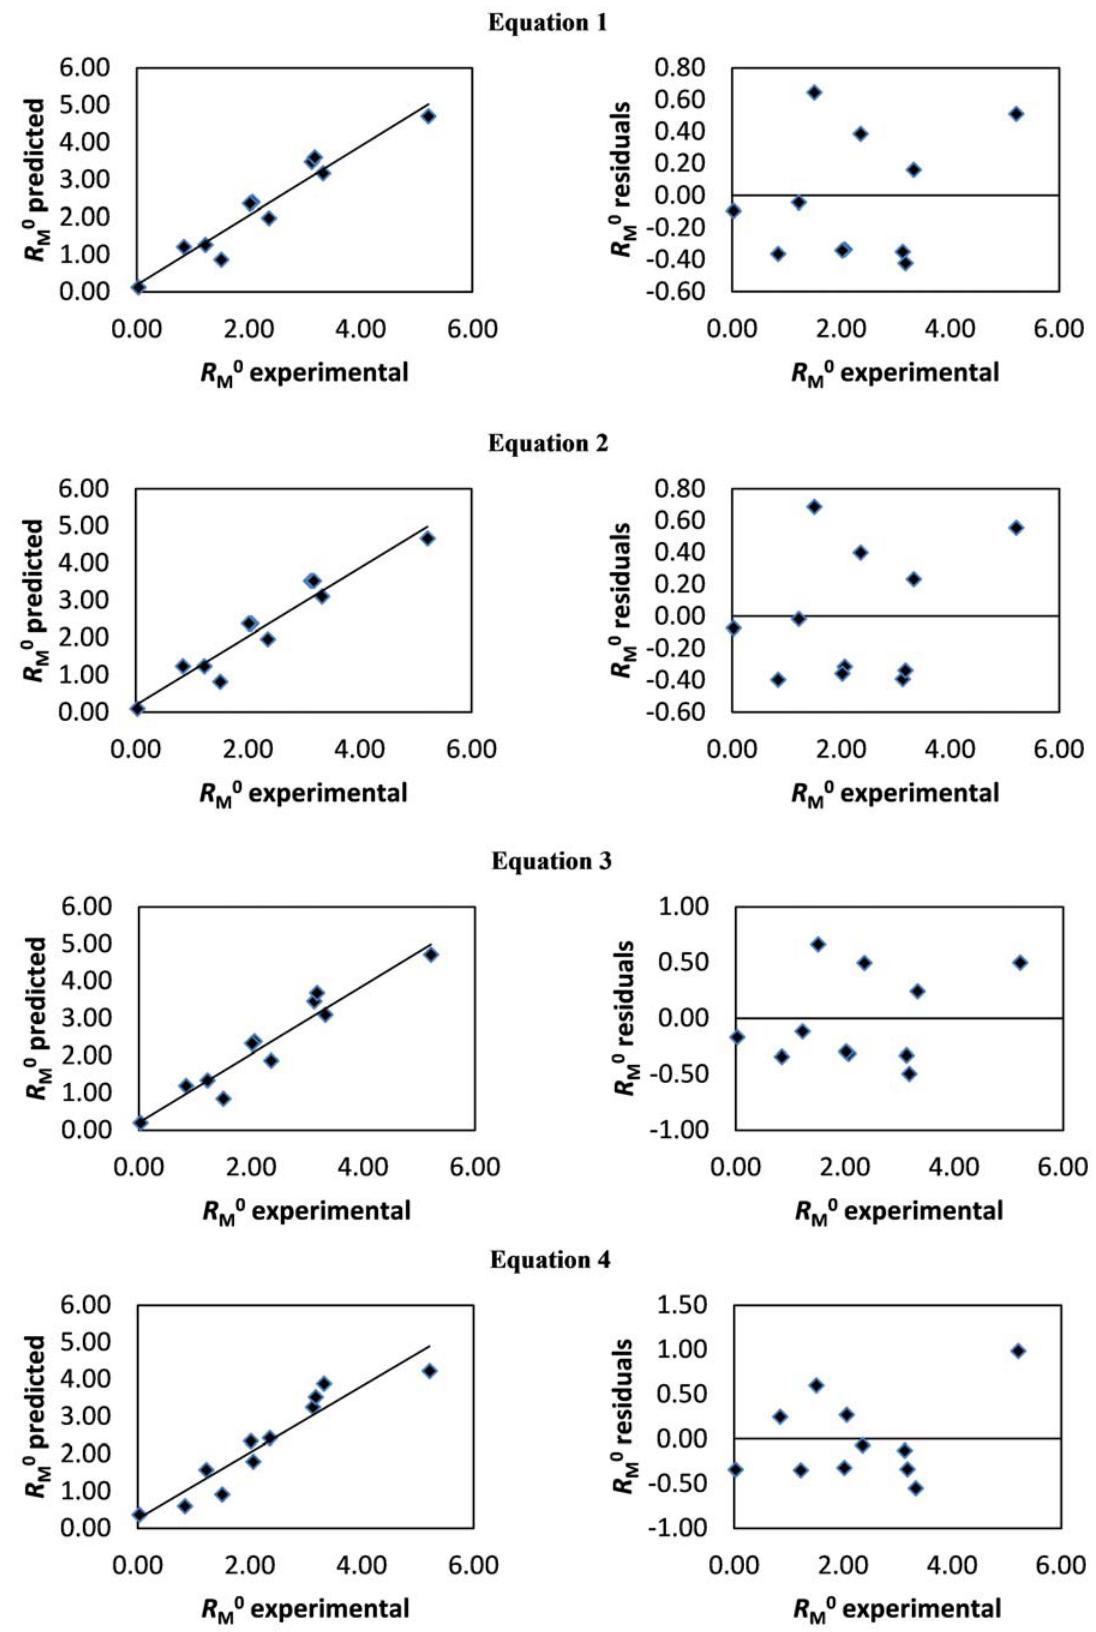
0 values and plots of residual values versus the experimentally observed R M